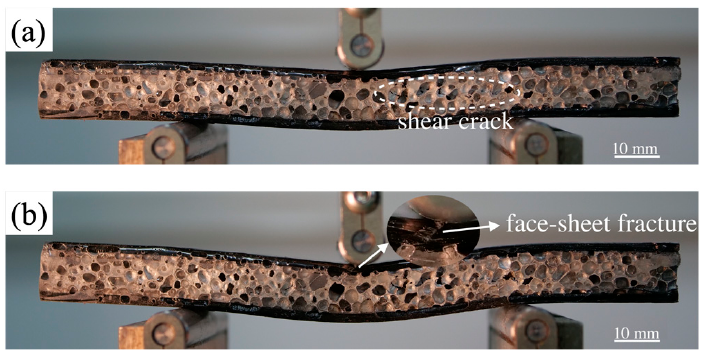
Figure 10. Deformation process of #10-0.37: ( a ) displacement = 2.86 mm; ( b ) displacement = 4.47 mm.